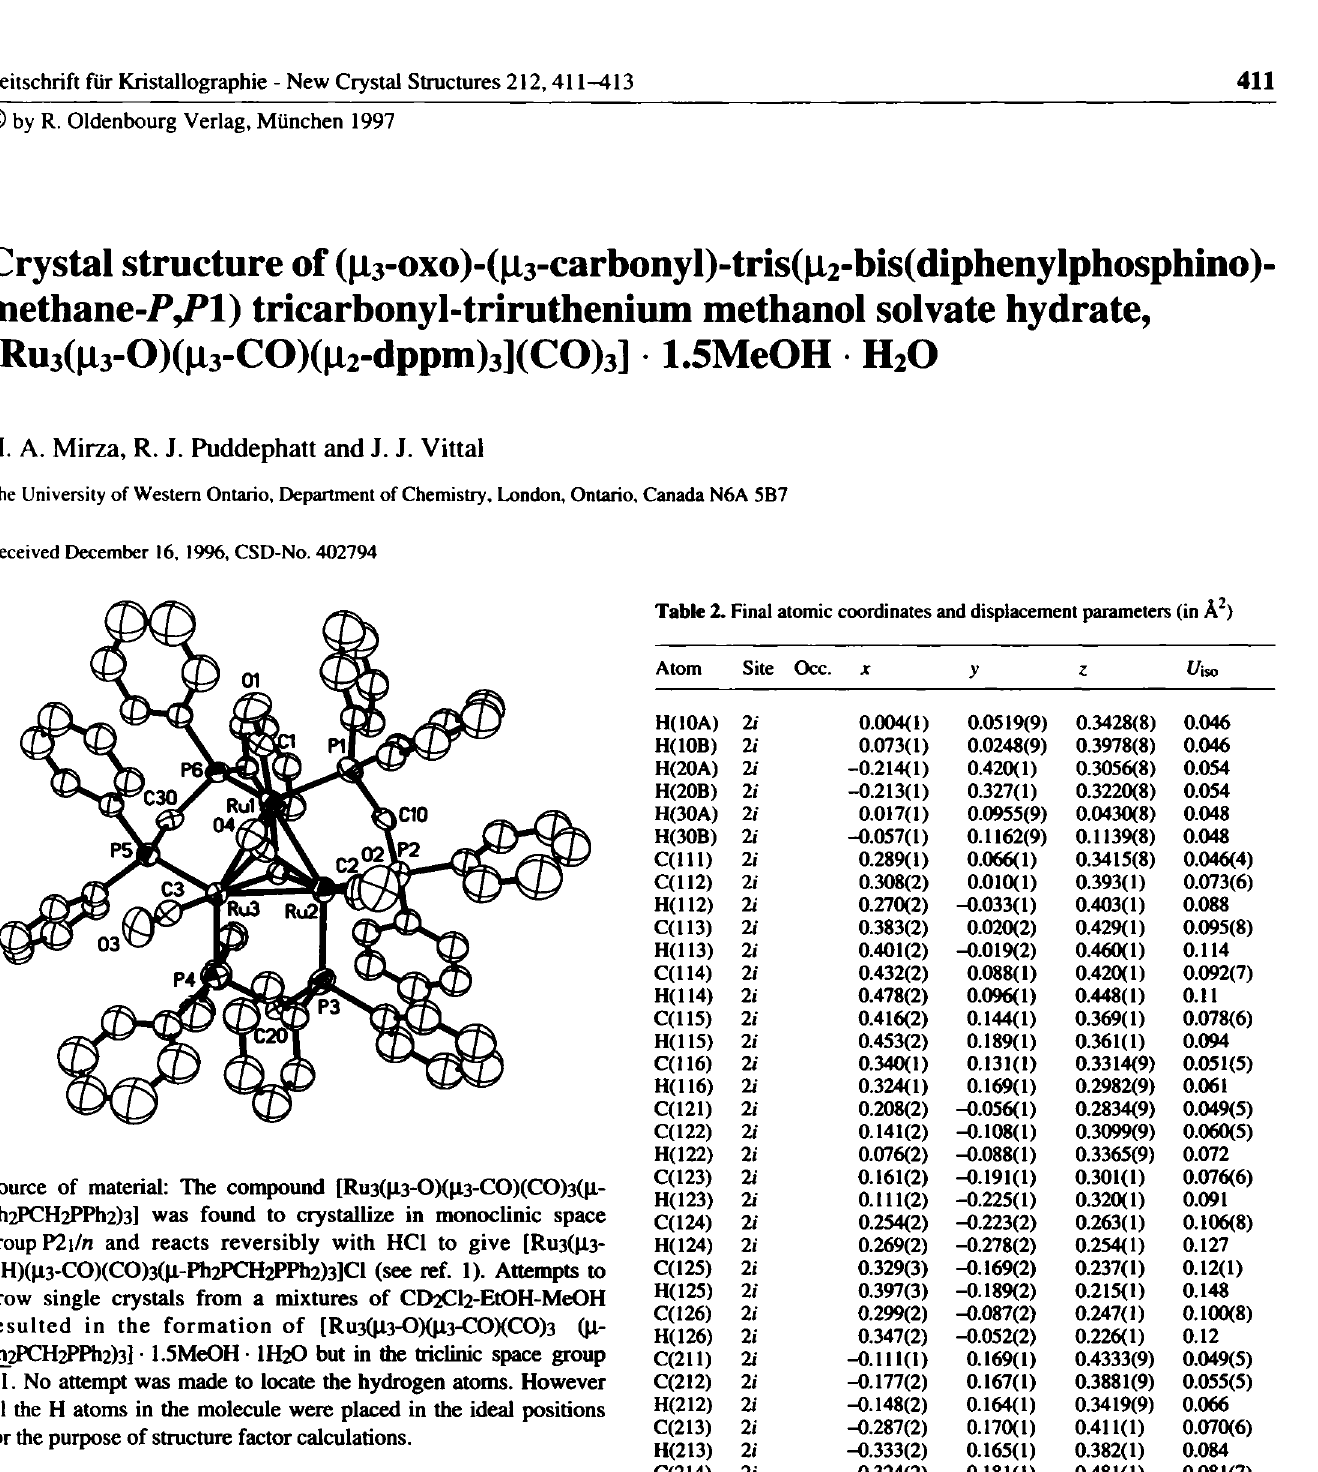
Table 1. Parameters used for the X-ray data collection